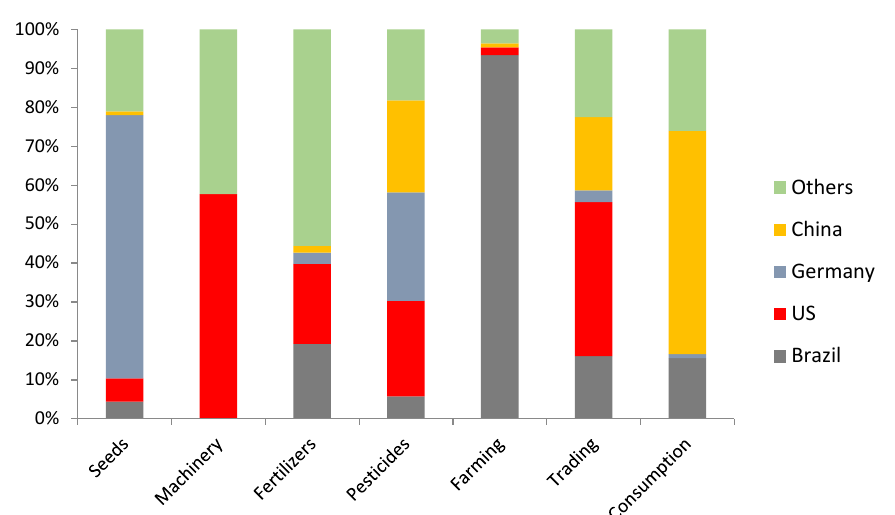
Figure 2. Market share held by Brazilian vis à vis multinational companies in key production stage of the soybean supply chain established in Brazil in 2020 (in %).